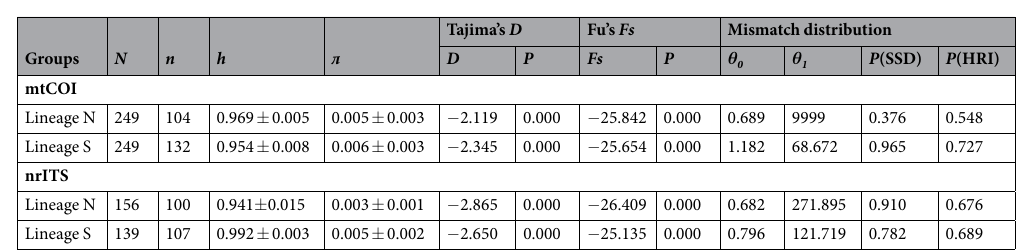
Table 4. Summary of molecular diversity and demographic analyses for two lineages of O. oratoria . Number of individuals ( N ), number of haplotypes or ribotypes ( n ), haplotype diversity ( h ), nucleotide diversity ( л ), Tajima’s D and Fu’s F S with corresponding P values for each lineage are shown. θ 0 and θ 1 are θ parameter before and after expansion; P values for the sum of squared deviations (SSD) and raggedness index (HRI) under the hypothesis of sudden expansion of each lineage are also